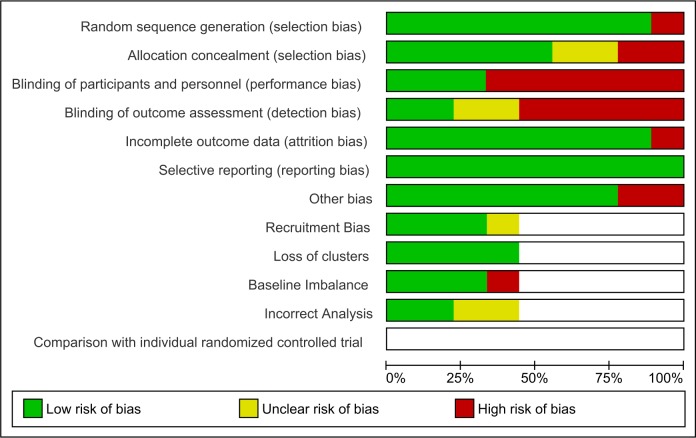
Risk of bias graph.Review authors' judgements about each risk of bias item presented as percentages across all included studies.